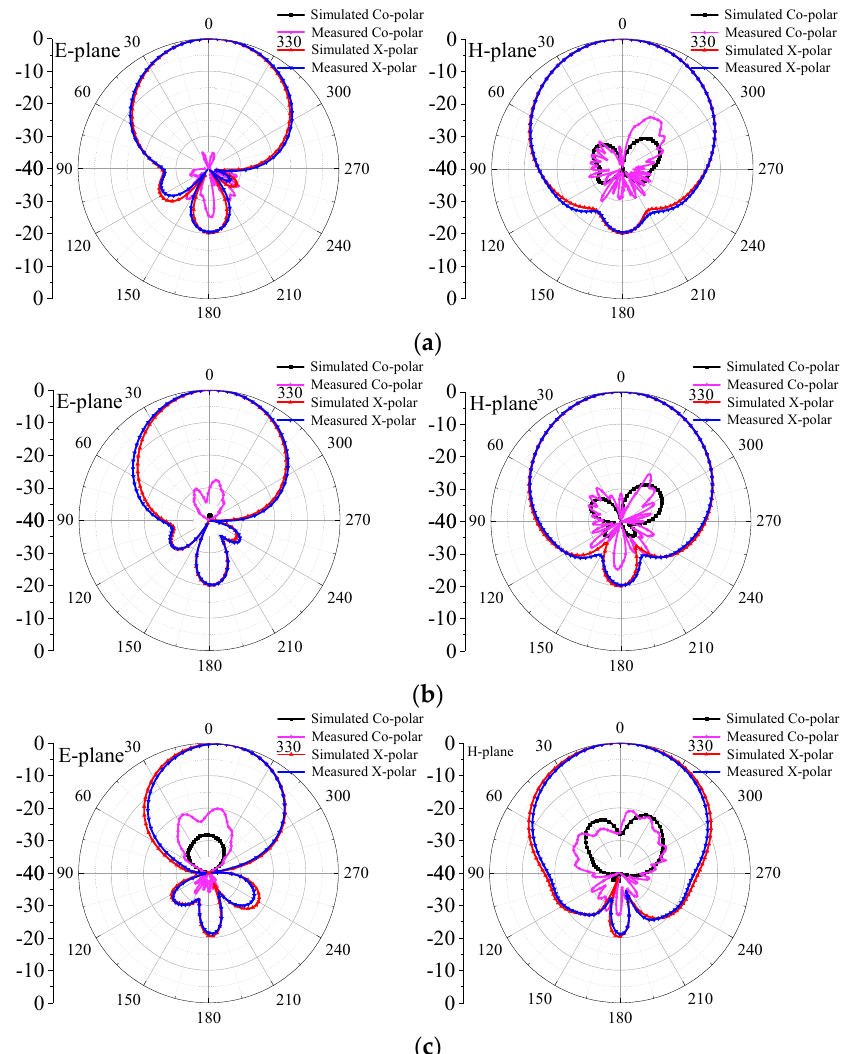
Figure 11. The Simulated and measured radiation patterns at different frequencies. ( a ) 3.2 GHz, ( b ) 4.2 GHz, ( c ) 5.2 GHz.